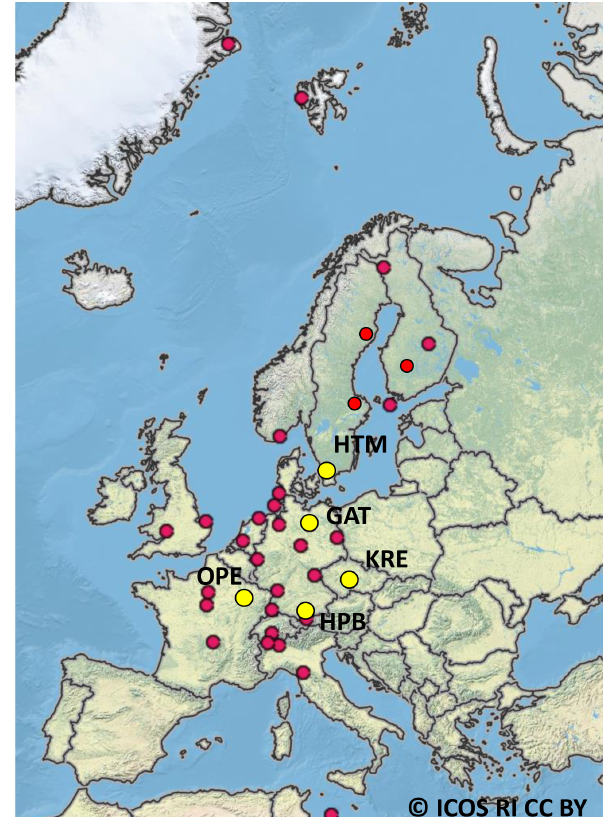
Figure 1. Map of ICOS atmosphere stations. The five stations in- cluded in this study are marked with big yellow dots: HTM – Hylte- mossa, GAT – Gartow, KRE – Kˇrešín, OPE – Observatoire Pérenne de l’Environnement, and HPB – Hohenpeißenberg. Sources: ESRI, US National Park Service and ICOS Carbon